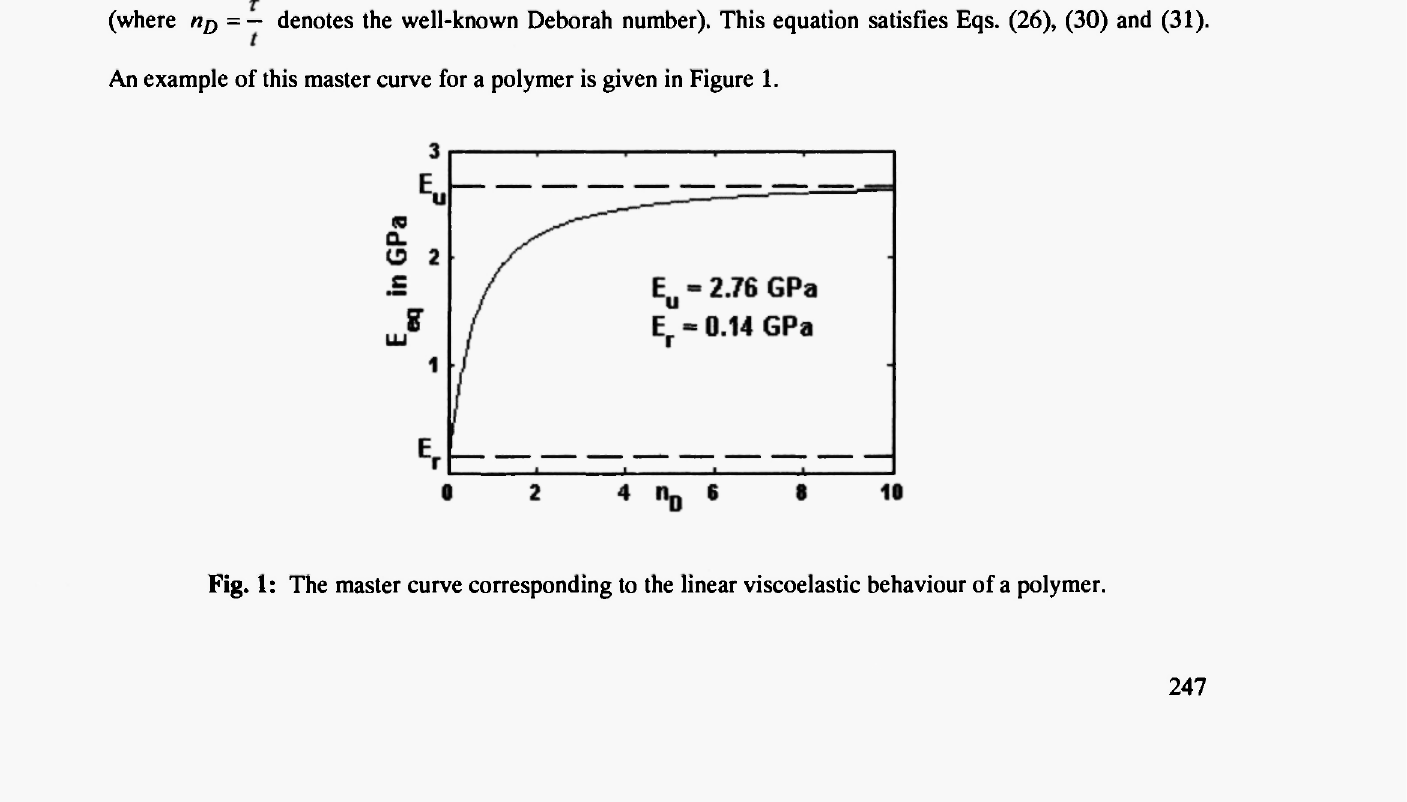
Fig. 1: The master curve corresponding to the linear viscoelastic behaviour of a polymer.